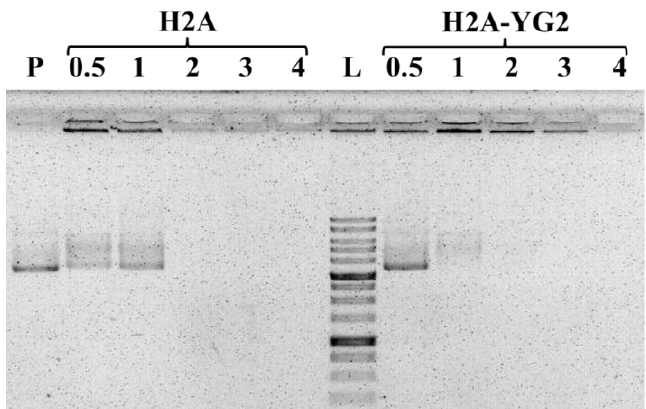
Figure 2. DNA neutralization by histones at different histone-DNA ratios studied by agarose gel electrophoresis. A total of 200 ng of plasmid DNA (P), SibEnzyme 1 Kb DNA Ladder (L), and complexes of histones H2A and H2A-YG2 at various N/P charge ratios (0.5, 1, 2, 3, and 4) with plasmid DNA are shown.